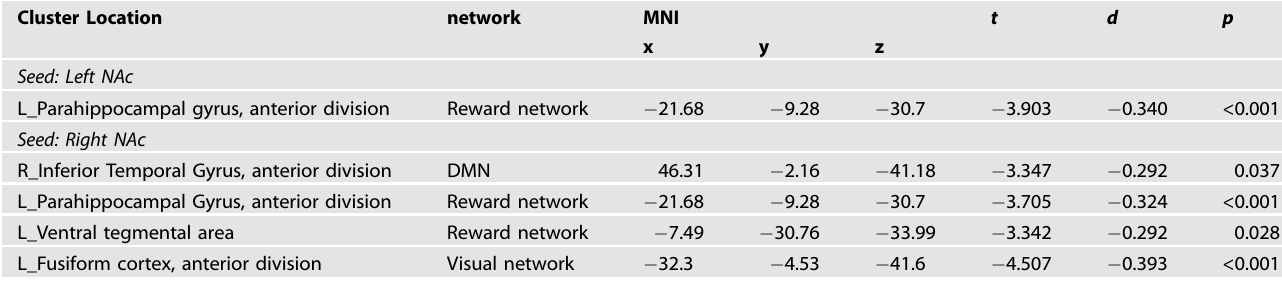
Table 2. The signi fi cant between-group differences in functional connectivity for the NAc ( p < 0.05, FDR-corrected). Cluster